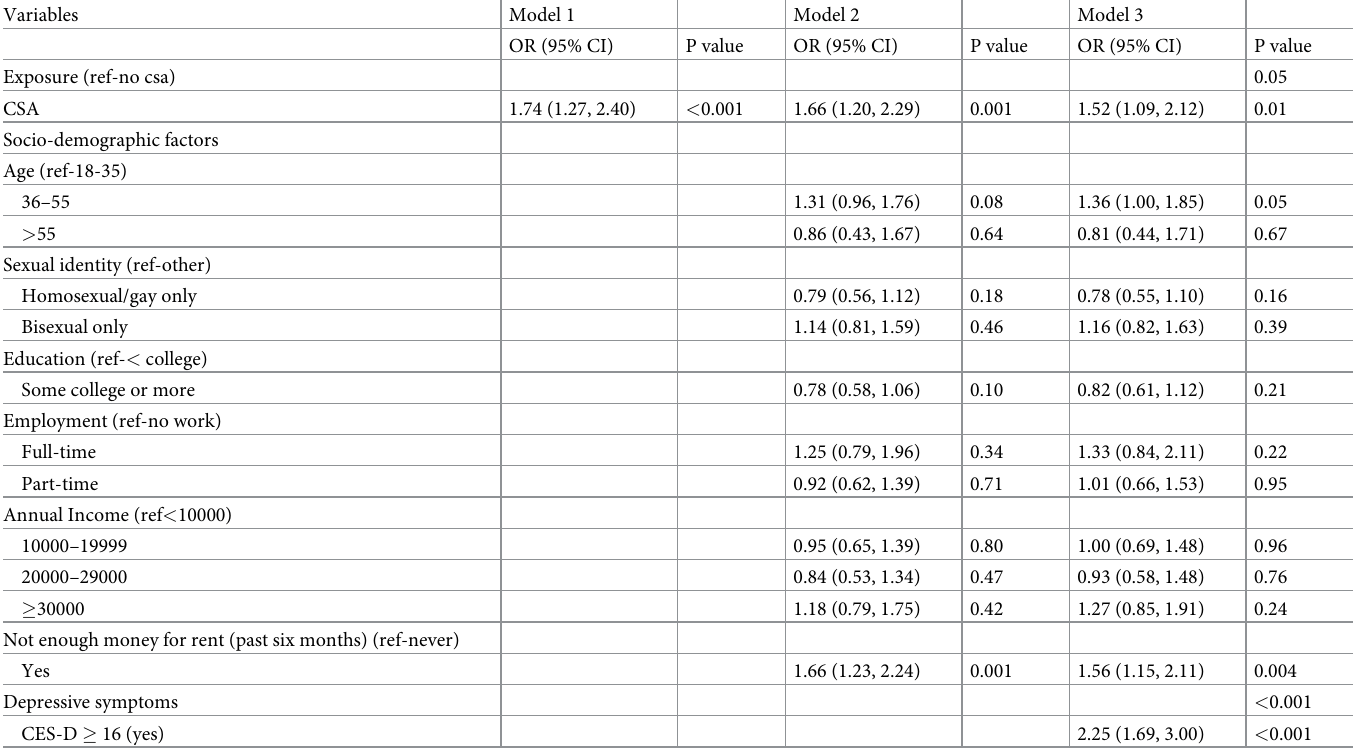
Table 4. Variables associated with alcohol use problems: Results from hierarchical logistic regression models (N =